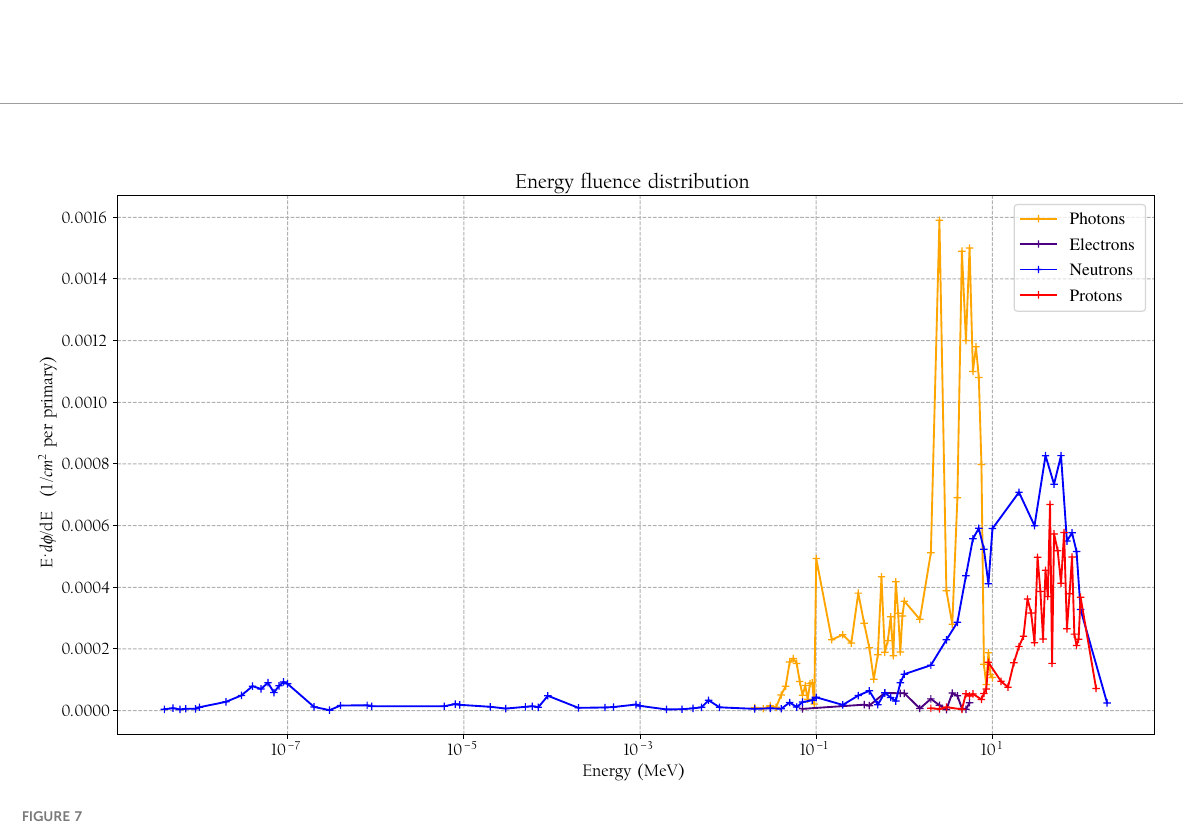
FIGURE 7 The simulated fl uence distribution at position A when the phantom is irradiated with 146-MeV protons and a range shifter is applied with a 23- cm air